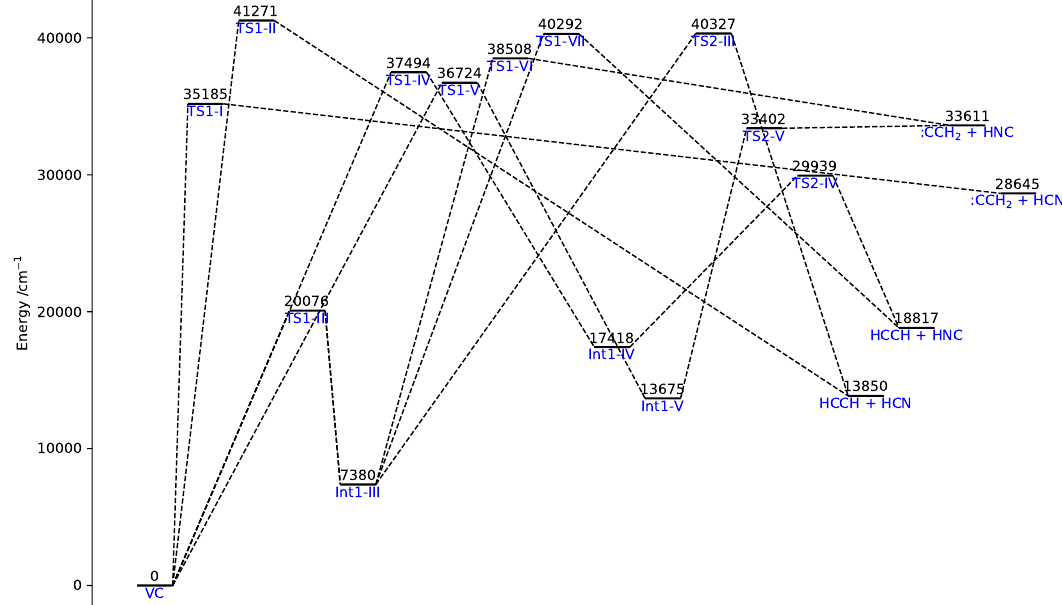
Figure 6. Reaction diagram for the dissociation of vinyl cyanide yielding HCN, HNC, :CCH 2 , and HCCH. All energies are relative to the reactant zero-point